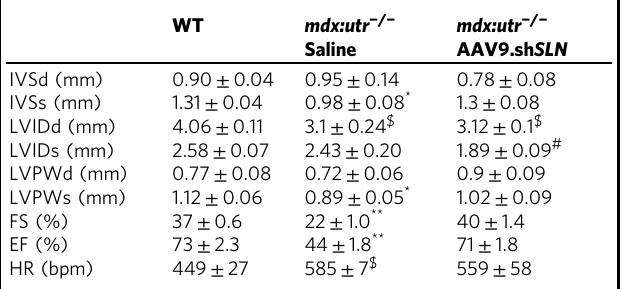
Table 2 Baseline echocardiographic data of AAV treated mdx:utr − / − mice